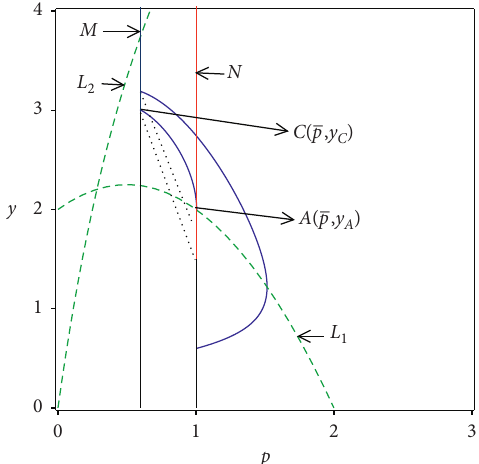
Figure 2: Phase set of system (7) with k � 2and a � 0 .